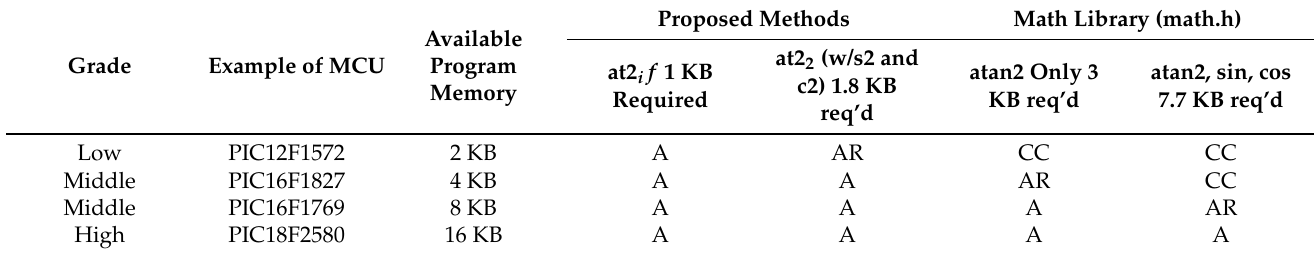
Table 7. Comparison of occupied program memory compiled with actual MCUs.